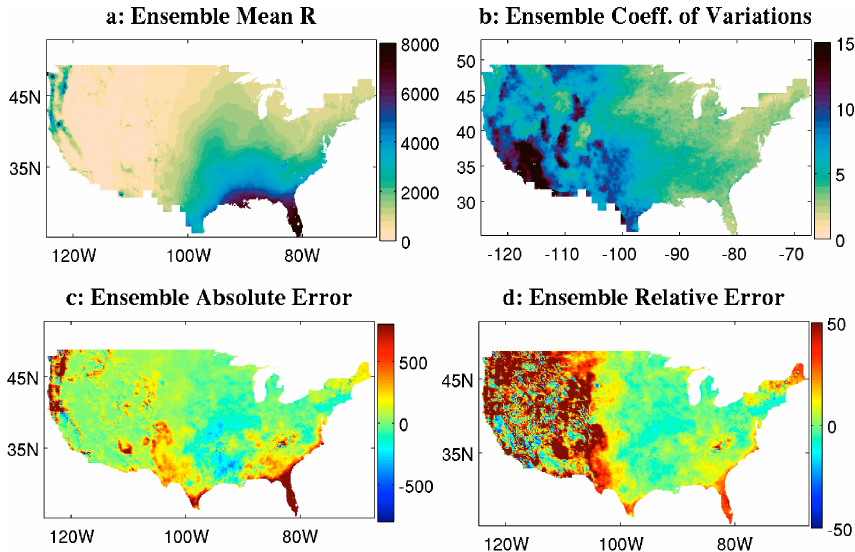
Figure 9. Evaluation of climate model estimates of R . Method 3 (the method of Fig. 6). (a) Ensemble mean erosivity. (b) Intra-ensemble standard deviation, divided by the ensemble mean erosivity (%). (c) Absolute error of the ensemble mean, compared to the target R . (d) Relative error of the ensemble